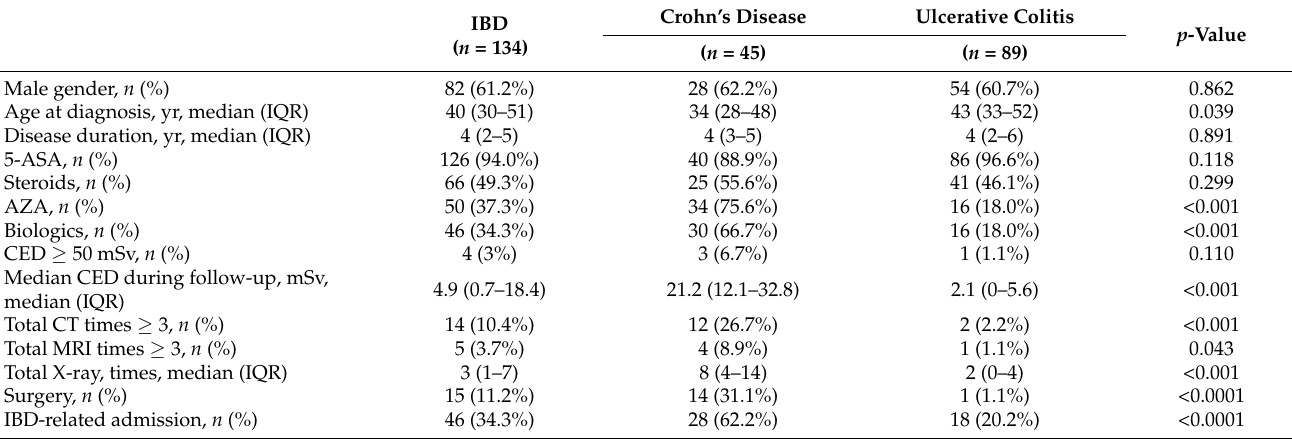
Table 2. The baseline characteristics of the study participants.